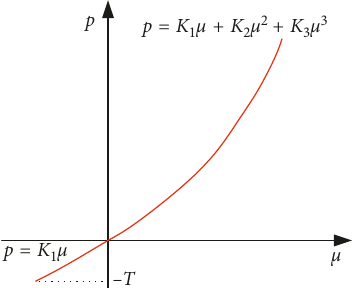
Figure 7: Relation between pressure and volumetric strain in JH2 model.